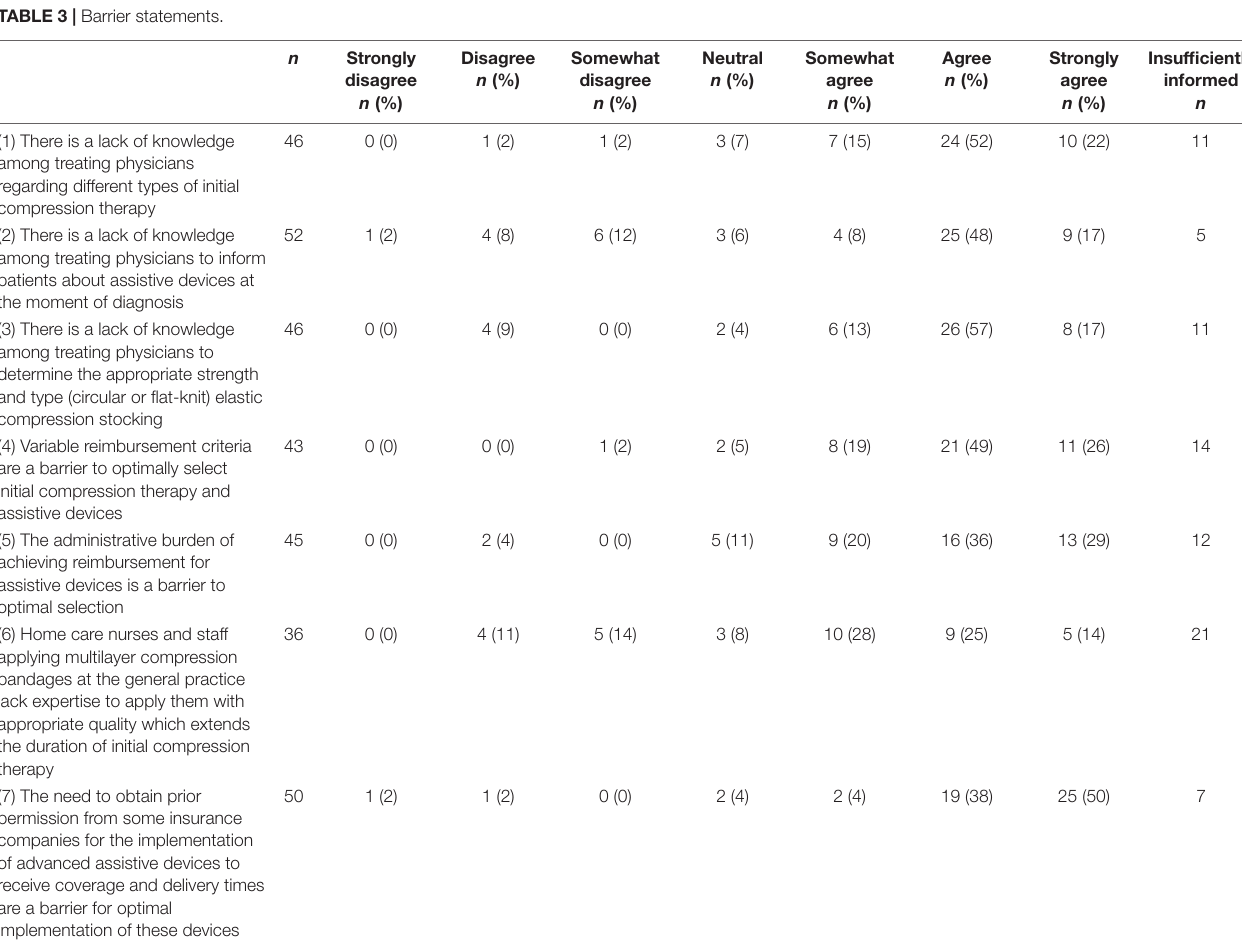
TABLE 3 | Barrier